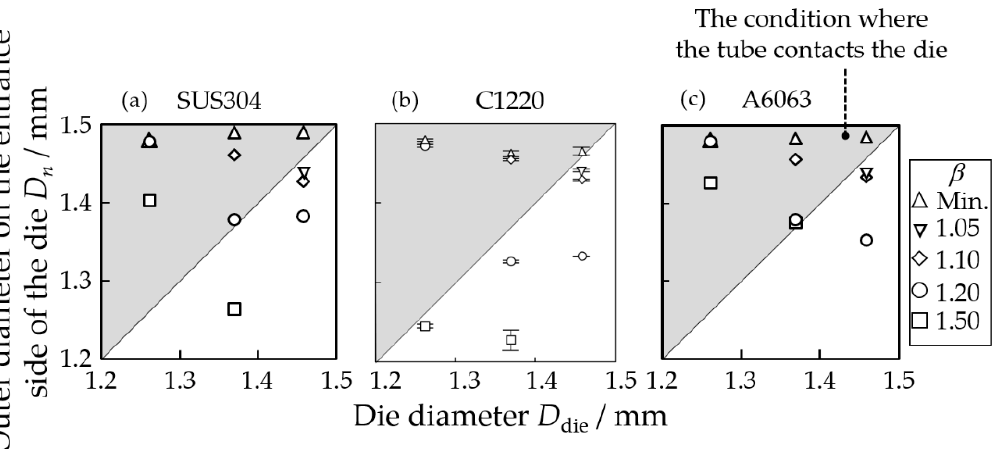
Figure 14. Outer diameter of the drawn tubes on the die entrance side for each material. ( a )